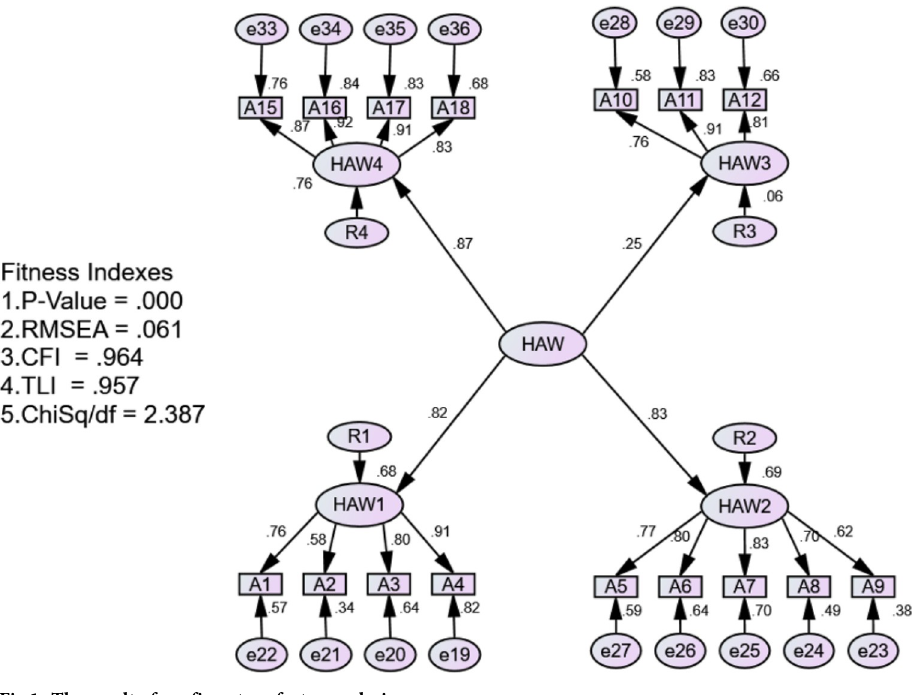
Fig 1. The result of confirmatory factor analysis.